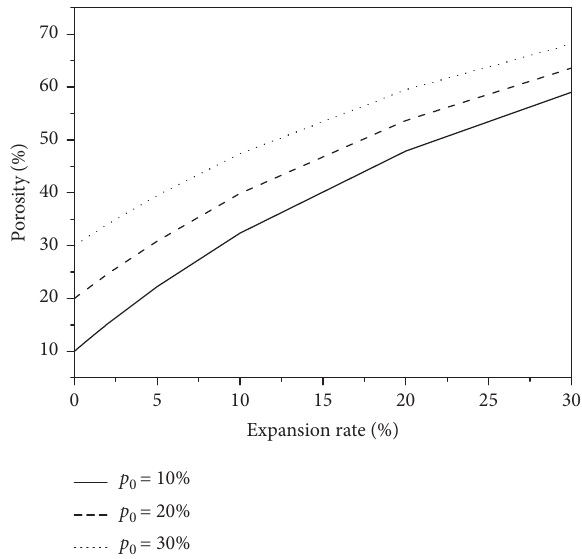
Figure 2: Relationships between porosity and expansion rate with different original